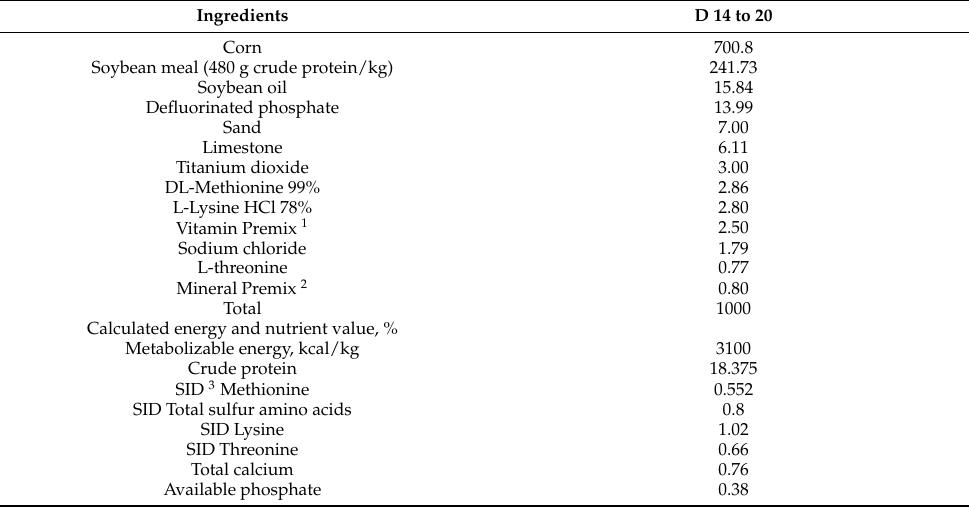
Table 1. Composition of the experimental diet (g/kg, as fed